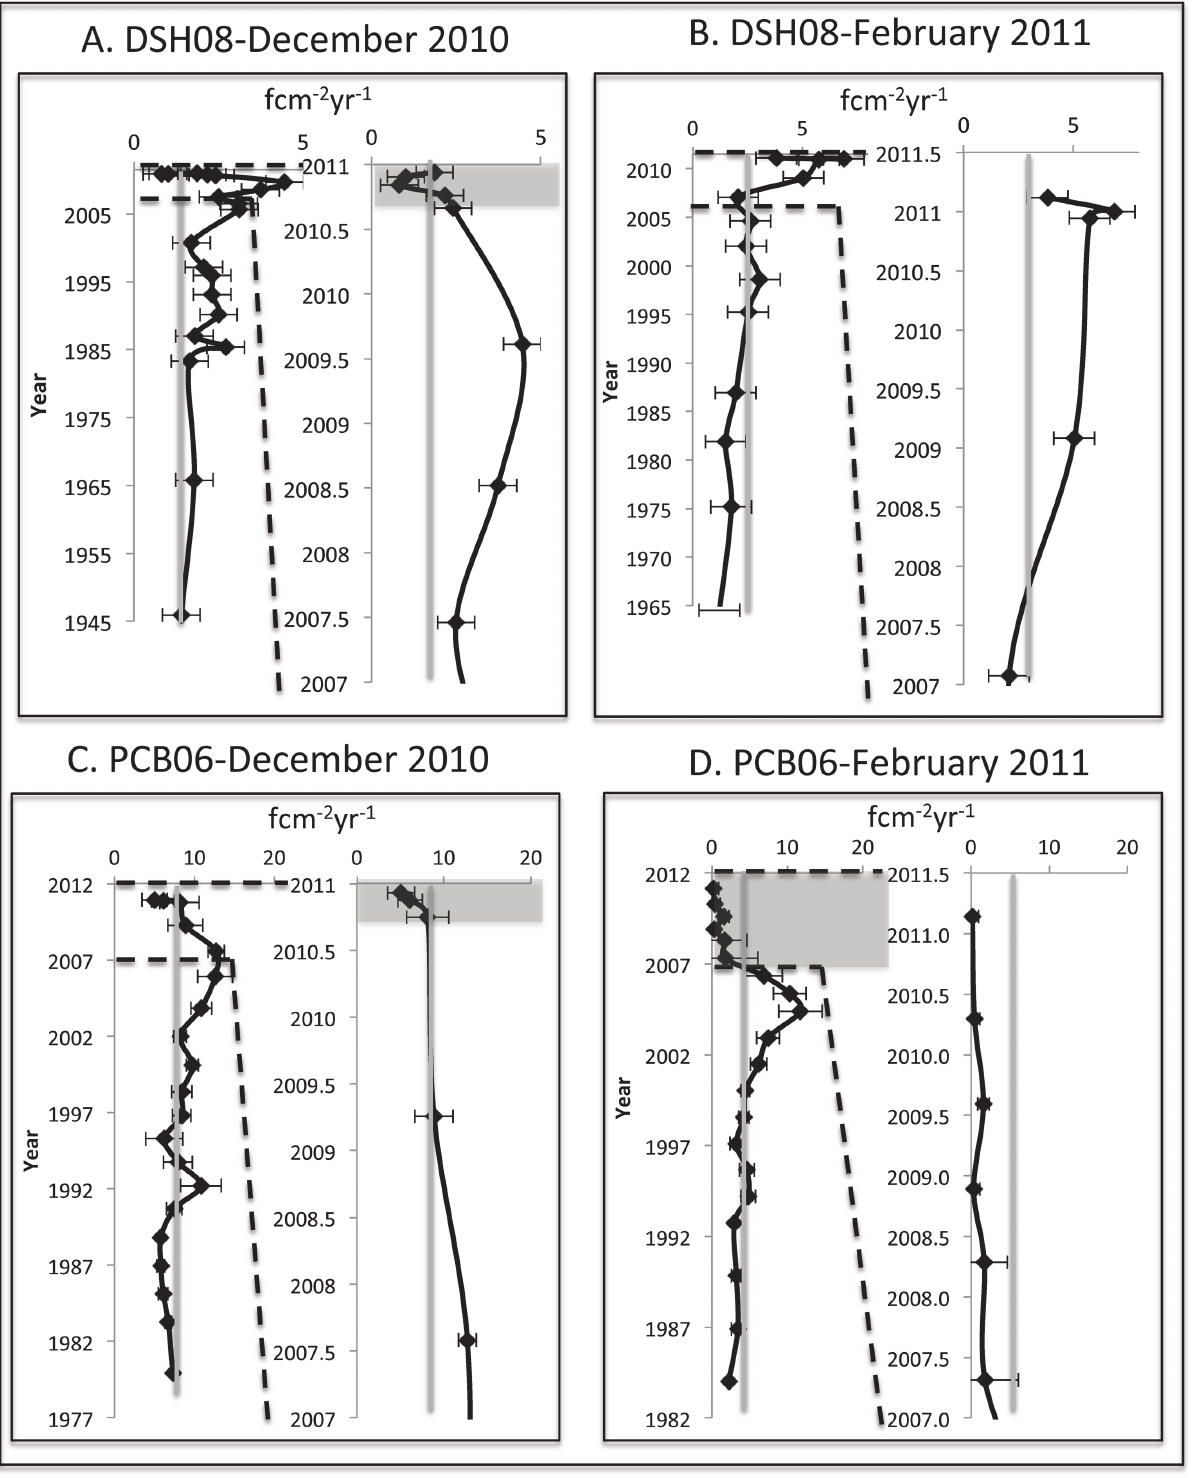
Fig 3. Benthic foraminiferal accumulation rate (BFAR) records for each sampling site with the period from 2007 – 2011 expanded for examination of the period during and after the DWH event. The gray areas represent the decline in BFAR and the gray lines represent the down-core mean BFAR.